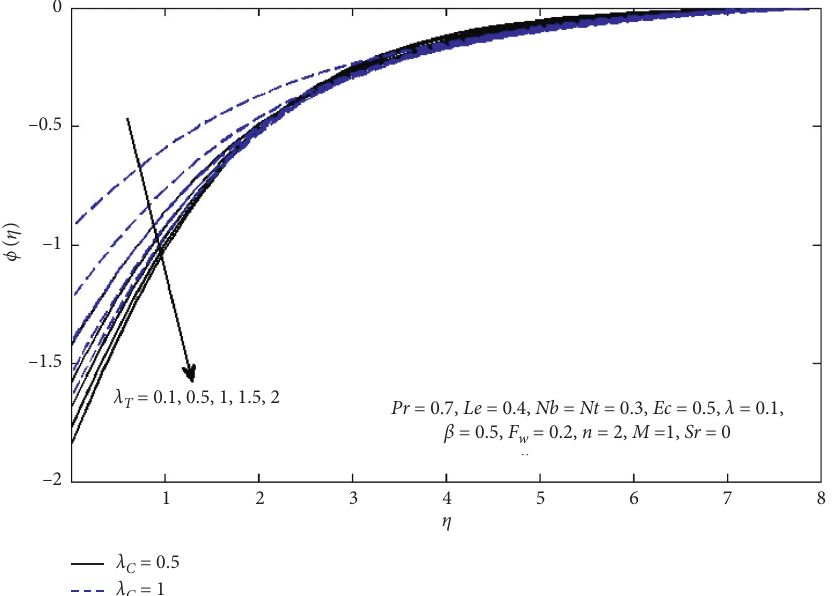
Figure 10: Variation of concentration ϕ concerning η with various values of λ